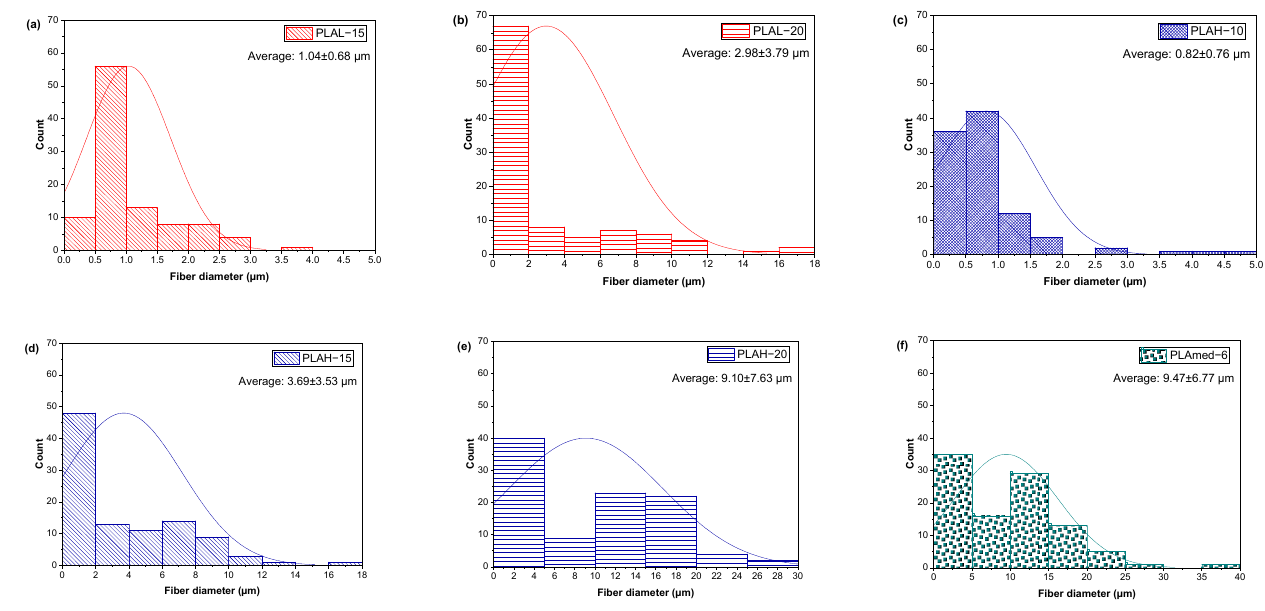
Figure 2. Histograms of electrospun fibers ( a ) PLAL − 15; ( b ) PLAL − 20; ( c ) PLAH − 10; ( d ) PLAH − 15; ( e ) PLAH − 20; and ( f ) PLAmed − 6.